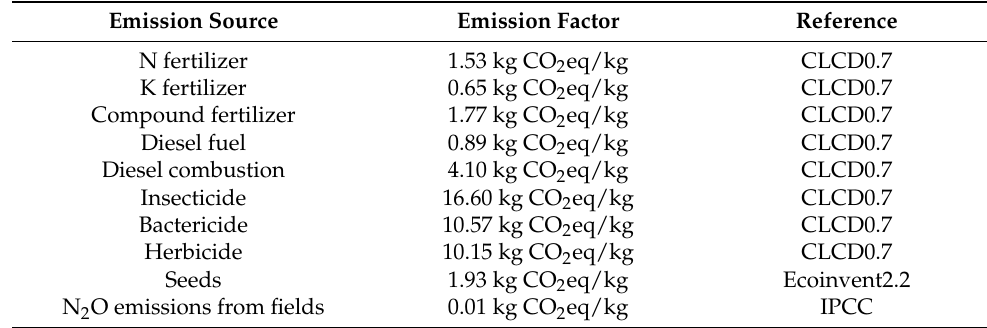
Table 3. Greenhouse gas (GHG) emission factors of different inputs and soils used for maize production in Jilin